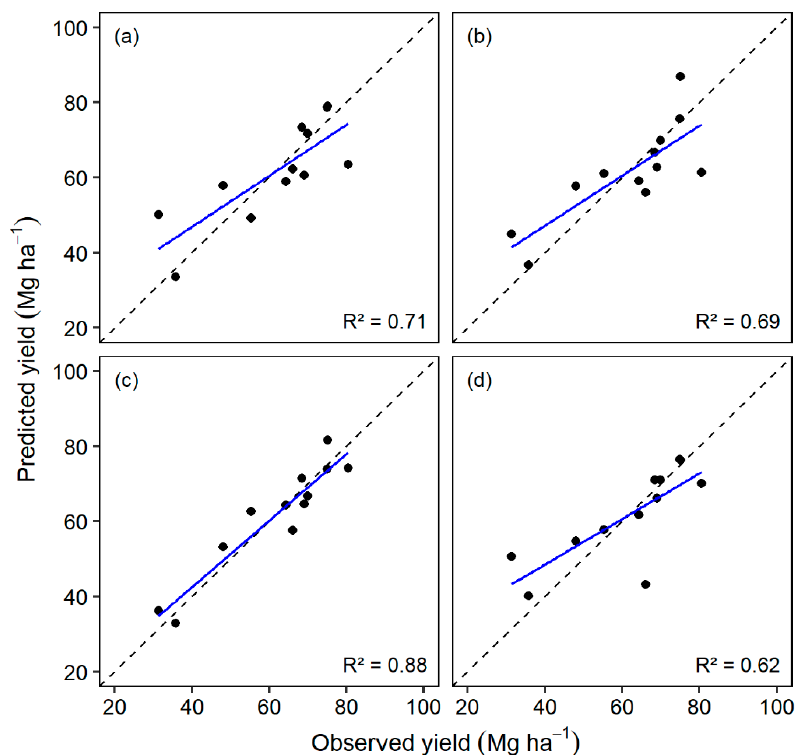
Figure 3. Relationship between the observed and predicted yields for the first (a), second (b), third (c), and fourth (d) flights.